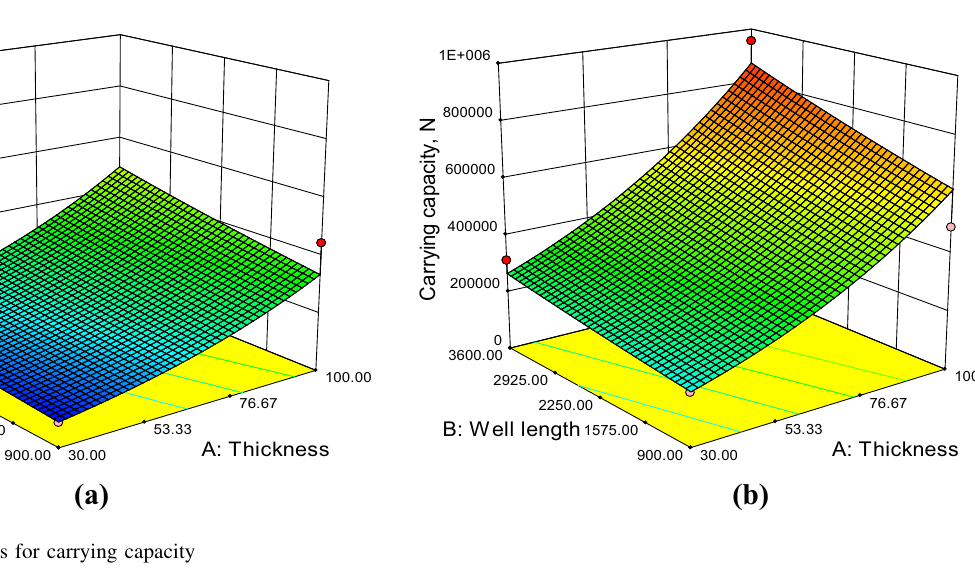
Fig. 9 Validation of developed relationship for carrying capacity. a Cross-plot of the predicted values carrying capacity versus the actual values of the carrying capacity. b Diagnostic plot that shows that the residuals of the regression are normally distributed